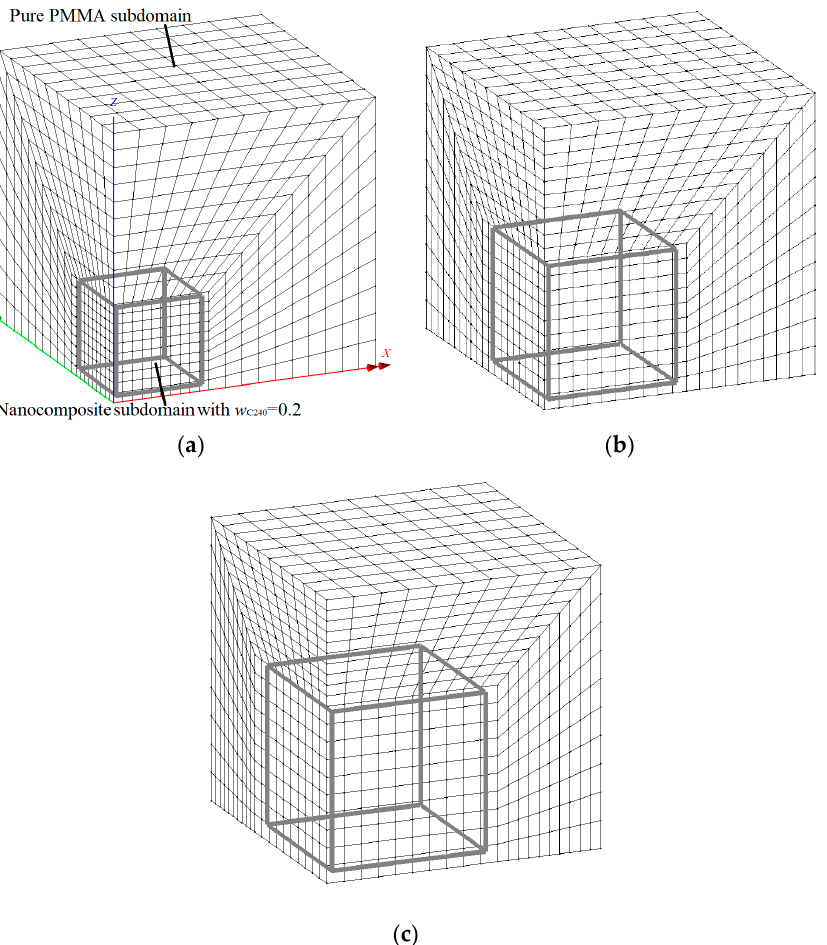
Figure 5. Finite element discretization of the nanocomposite RVE with a mass fraction of ( a ) w C240 = 0.01, ( b ) w C240 = 0.03, and ( c ) w C240 = 0.05 (1/8 of the periodic volume of the whole system domain).